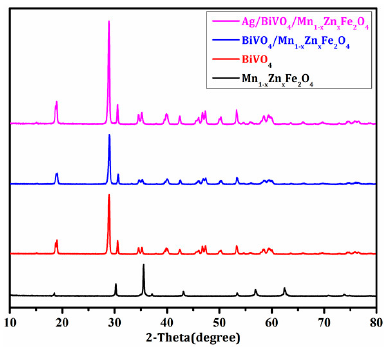
Figure 1. XRD patterns of Mn 1 − x Zn x Fe 2 O 4 , BiVO 4 , BiVO 4 /Mn 1 − x Zn x Fe 2 O 4 , and Ag/BiVO 4 /Mn 1 − x Zn x Fe 2 O 4.